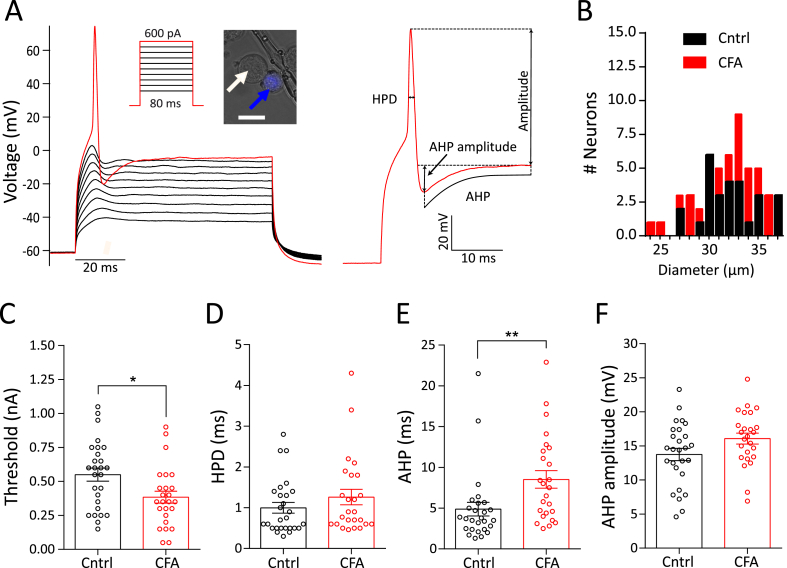
Action potential properties of knee neurons following acute knee inflammation. A) Action potential generation protocol (inset) and response along with a close-up of an evoked action potential from a knee neuron showing the different parameters measured. Example of a labeled knee neuron (blue arrow) and an unlabeled neuron (white arrow) shown in inset. Scale bar indicates 25 μm. B) Frequency distribution of neuronal diameter in μm of CFA (red, n = 25) and Cntrl (black, n = 27) neurons. C-F) Distribution of threshold (C), half peak duration (HPD) (D), afterhyperpolarization (AHP) (E) and AHP amplitude (F) after 4-h in culture. Error bars indicate SEM, * indicates p < 0.05, ** indicates p < 0.01, unpaired t-test. (For interpretation of the references to colour in this figure legend, the reader is referred to the Web version of this article.)